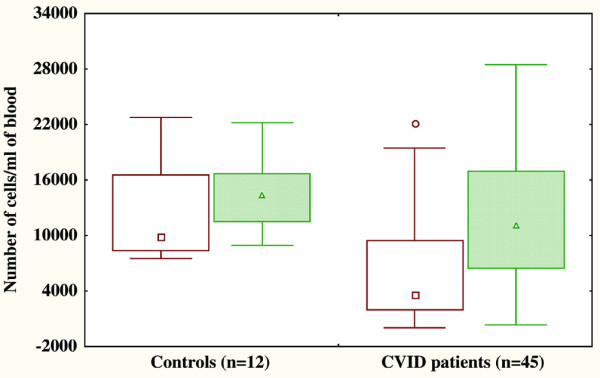
Absolute counts of pDCs and mDCs in 45 CVID patients and 12 controls. Medians of absolute counts of peripheral blood lymphoid dendritic cells (pDCs) (white boxes; □∘) and myeloid DCs (shaded boxes; Δ) in 12 control subjects (respective median values, 9,829/ml and 14,361/ml; extreme values, 7,514 to 22,769/ml and 8,941 to 22,204/ml) and 44 patients with common variable immunodeficiency (CVID) (respective median values, 3,647/ml and 11,100/ml; extreme values, 19 to 22,144/ml and 342 to 28,472/ml). The symbol within each box represents the median value. The upper and lower edges of the boxes represent the 25th and 75th percentiles, and the bars on the whiskers represent the 10th and 90th percentiles. s represents an aberrant value. Statistical comparisons between the two populations (nonparametric Mann–Whitney U  test): P  = 0.002 for pDCs and P  = 0.1 for mDCs.